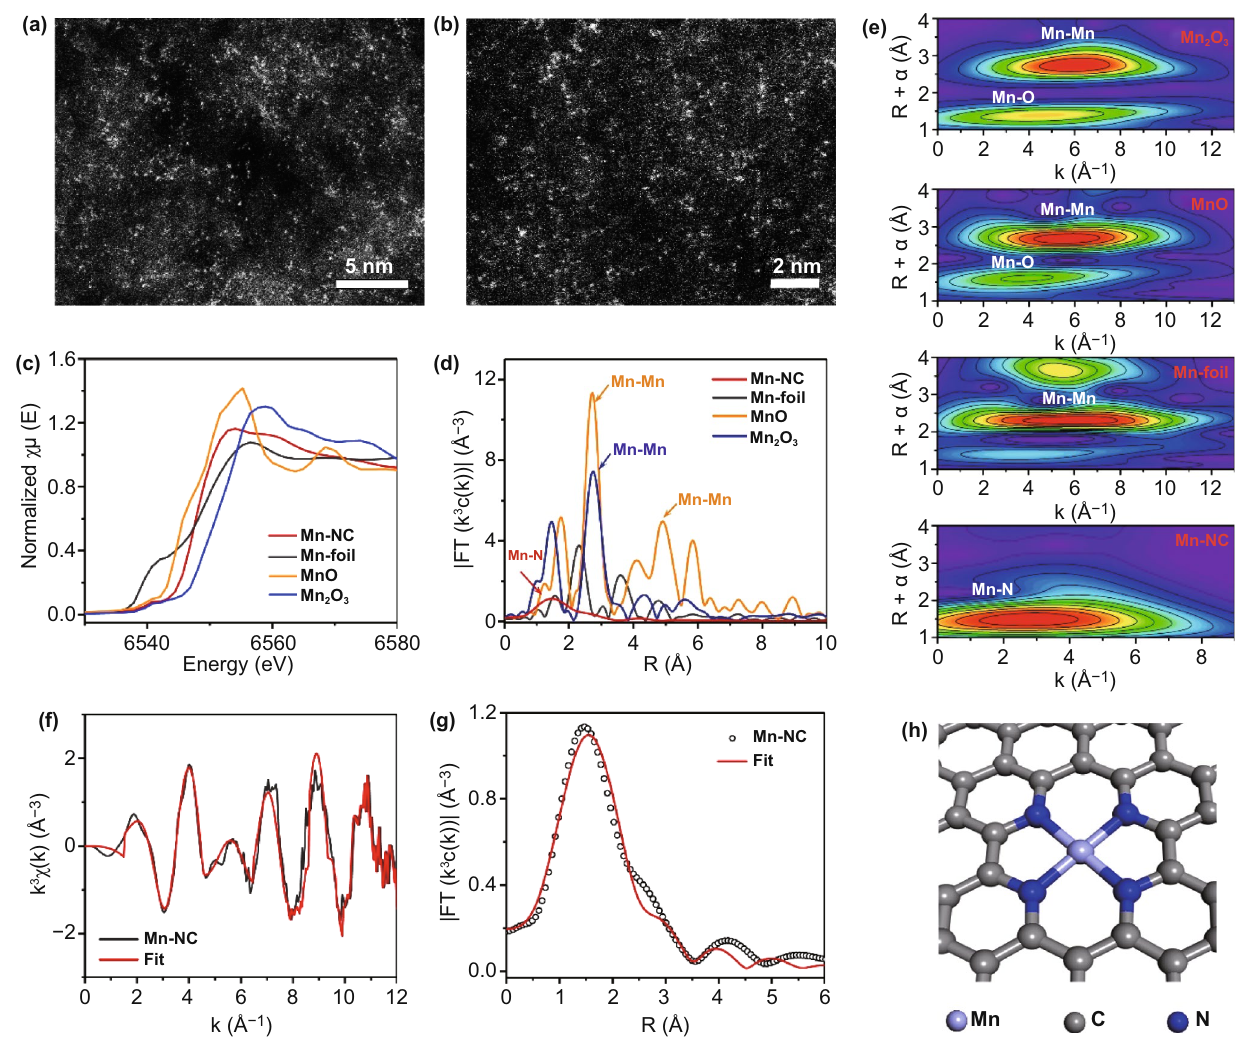
Fig. 4 a–b AC HAADF-STEM images of 3D Mn–NC. Isolated single Mn atoms are highlighted by yellow circles. c Normalized XANES spectra at the Mn K-edge of the Mn foil, MnO, Mn 2 O 3 , and Mn–NC. d FT-EXAFS spectra of the Mn foil, MnO, Mn 2 O 3 , and Mn–NC. e WT of the Mn foil, MnO, Mn 2 O 3 , and Mn–NC. f EXAFS fitting curve for Mn–NC in the k -space. g EXAFS fitting curve for Mn–NC in the R -space. h Configuration of